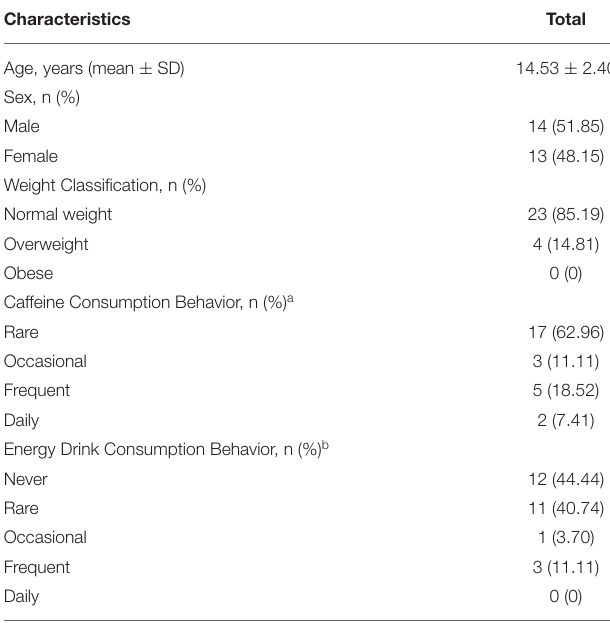
TABLE 1 | Study participants’ characteristics ( n = 27).